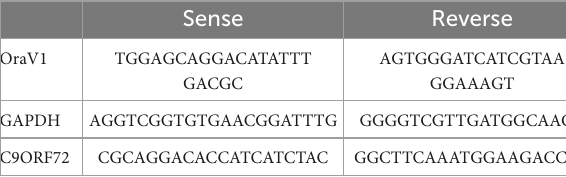
TABLE 1 List of primers used for qPCR.